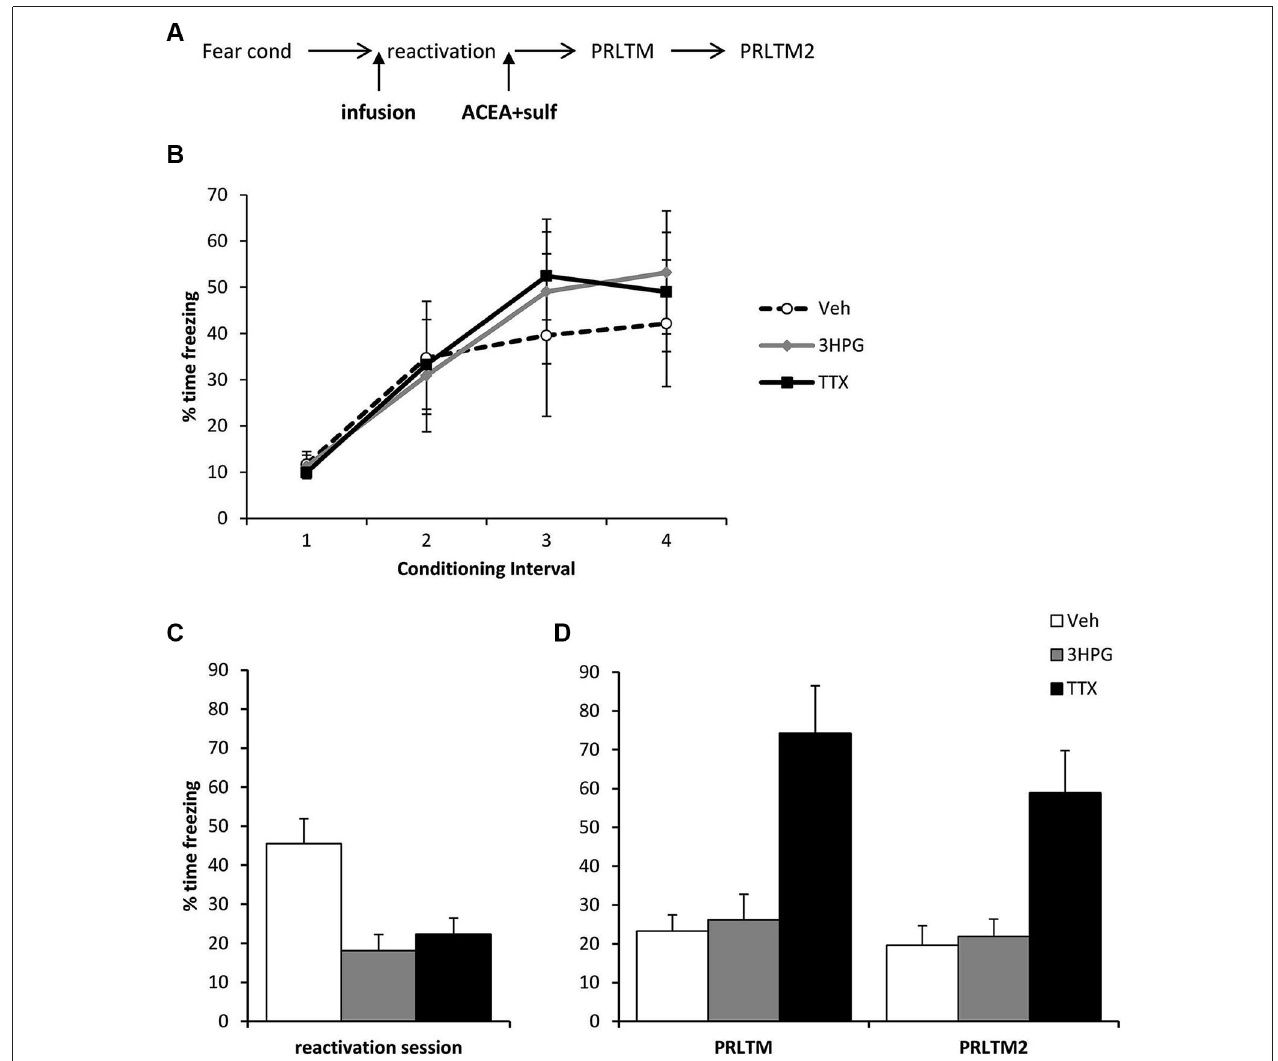
3HPG and TTX impaired the expression of contextual fear at memory reactivation. ( D ) TTX impaired contextual fear memory destabilization. Contextual freezing was assessed 24 h (PRLTM) and 7 days (PRLTM2) after memory reactivation. TTX-infused rats froze more than 3HPG- and vehicle-infused rats at both tests. Data presented as mean + s.e.m. ( N = 5 per group).